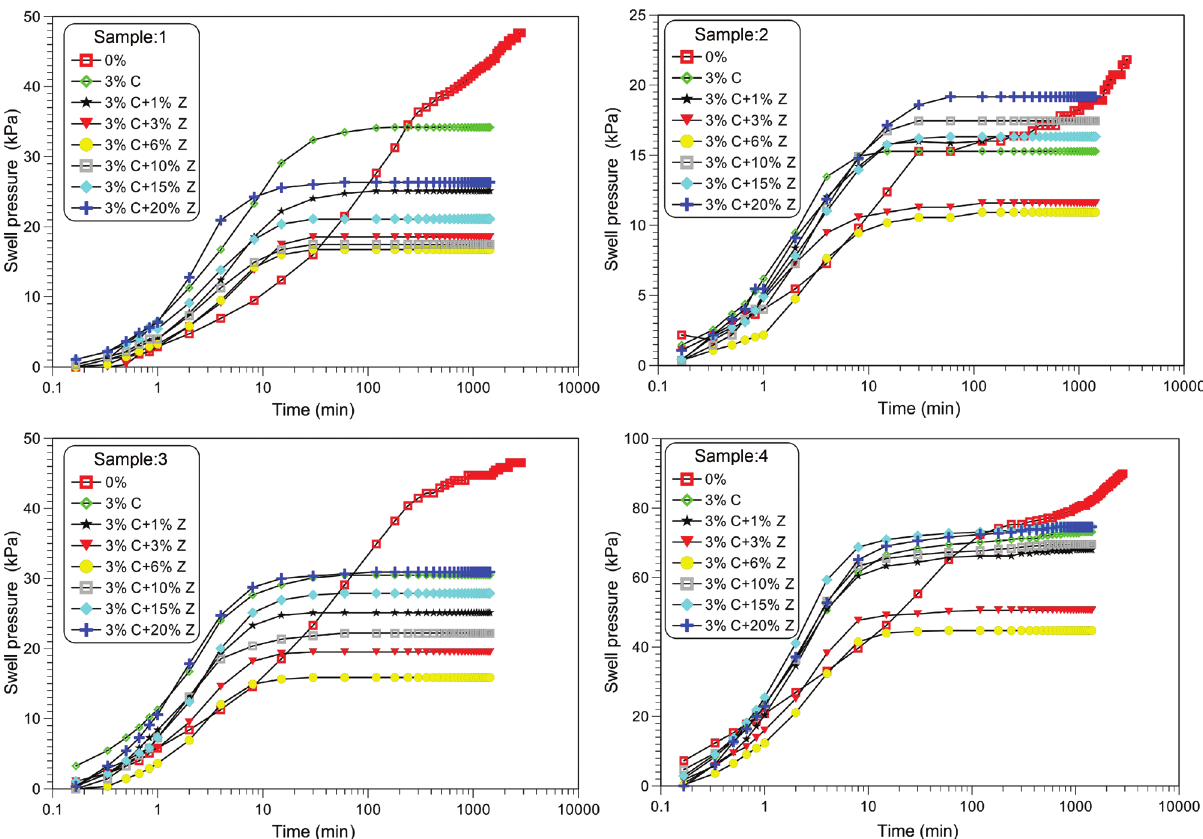
Figure 7 Swell pressure vs. time plots for the soil samples mixed with different additive contents.